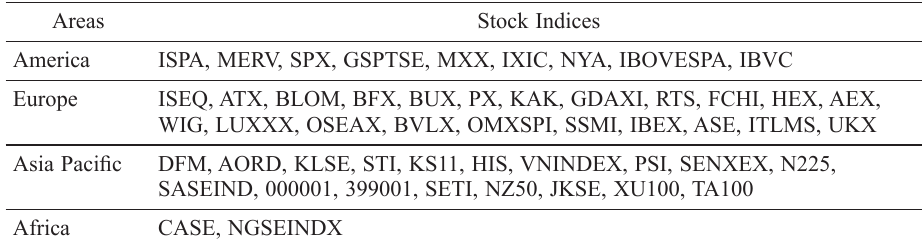
Table 1. Major elements of global stock